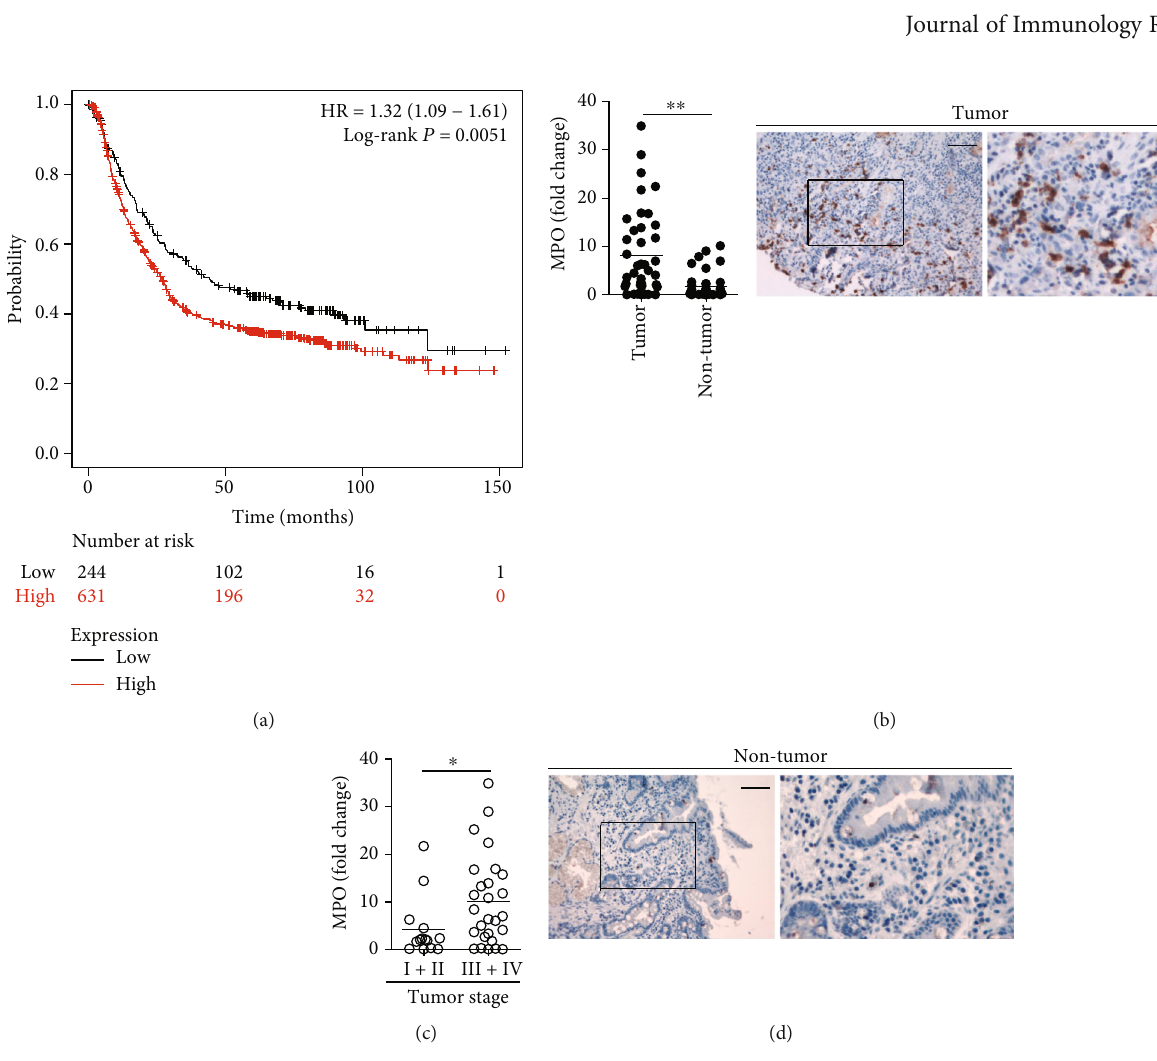
Figure 1: Neutrophils are enriched in human GC environment with tumor progression and associated with poor patient survival. (a) Kaplan- Meier plots for intratumoral MPO expression in GC patients (overall survival in Kaplan-Meier plotter website). (b) Expression of MPO between autologous tumor and nontumor tissues ( n = 41 ) was analyzed. (c) Expression of MPO in GC tumors among TNM stages was compared. Human GAPDH mRNA level served as a normalizer, and its level in nontumor tissues served as a calibrator. The relative gene expression was expressed as fold change of relevant mRNA calculated by the ΔΔ Ct method. (d) Representative analysis of MPO + (brown) neutrophil distributions in tumor and nontumor tissues of GC patients by immunohistochemical staining. Scale bars: 100 microns. MPO: myeloperoxidase. The horizontal bars in (b) and (c) represent mean values. Each ring or dot in (b) and (c) represents 1 patient. ∗ P < 0 : 05 , ∗∗ P < 0 : 01 , and n.s. P > 0 : 05 for groups connected by horizontal